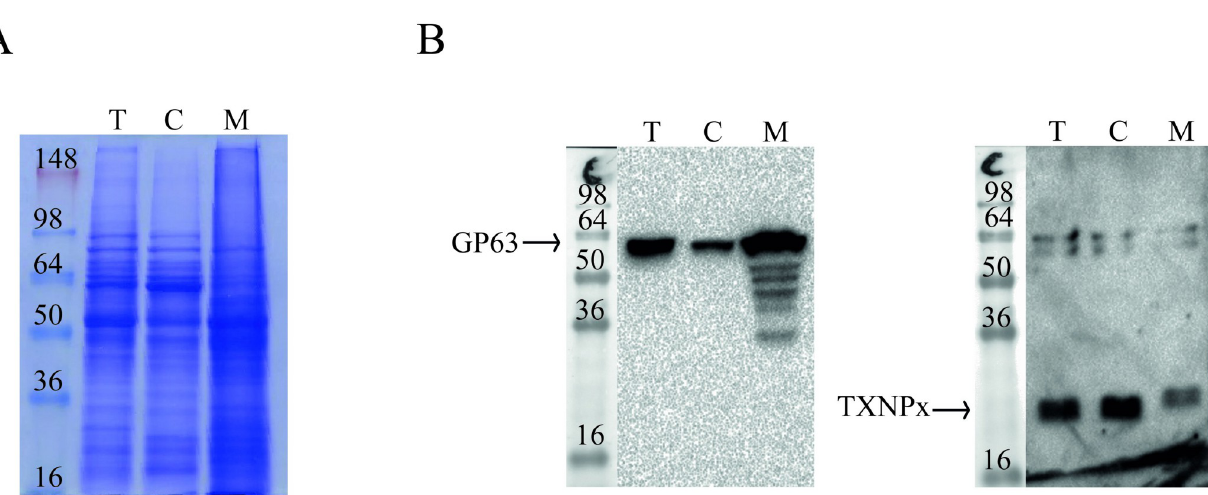
LV79 promastigote day four cultures. Membrane enrichment was confirmed by Western blot with anti-GP63 and anti-TXNPx antibodies before proteomic analysis, as shown in S2 Fig. Proteomes of the three samples of each strain were analyzed and 1659 proteins were iden- tified, listed in S1 Table (Fig 3A). Principal component analysis based on all identified pro- teins efficiently clustered PH8 and LV79 samples (Fig 3B). From these, 1557 were identified